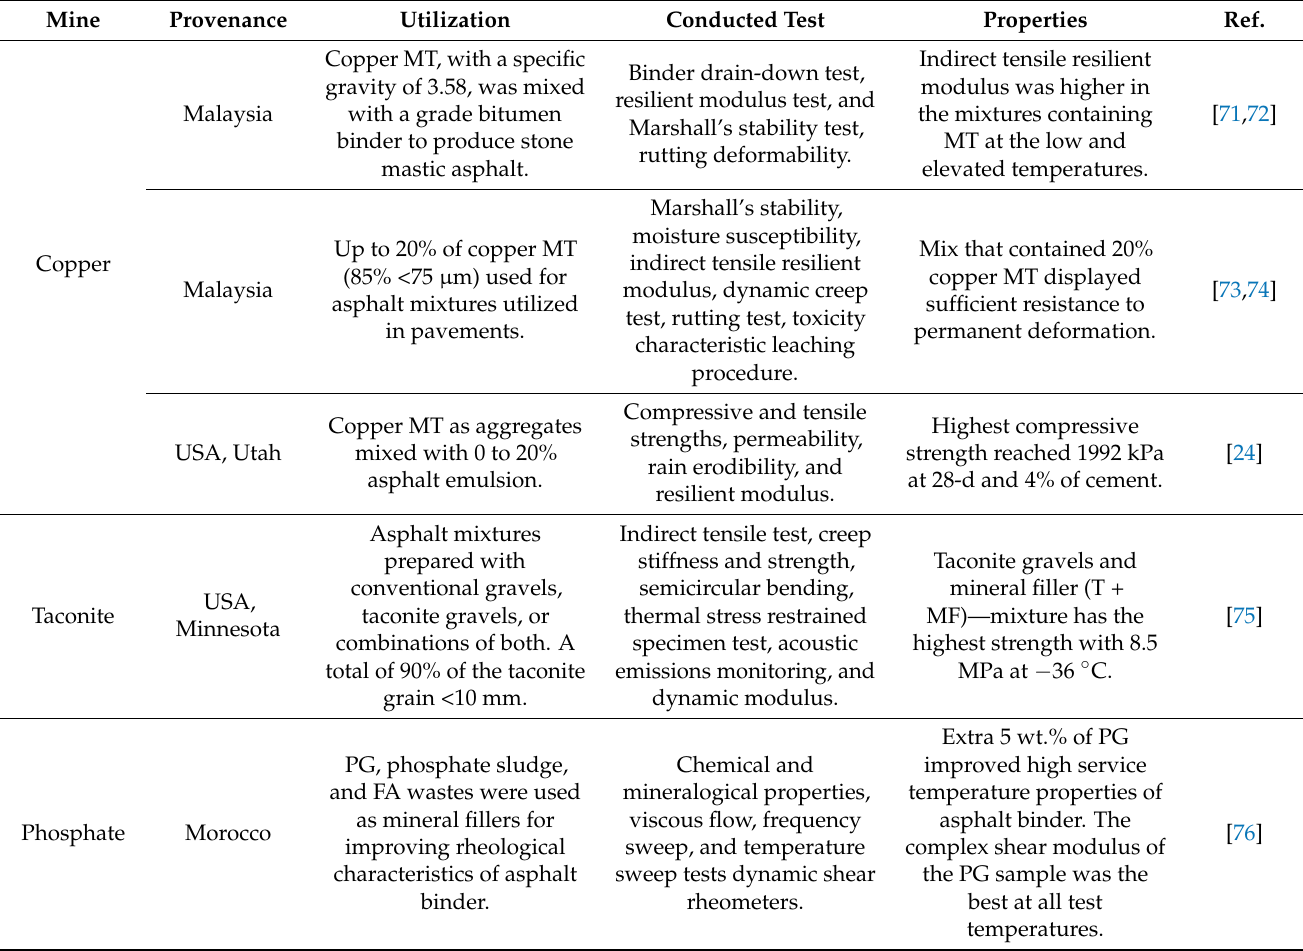
Table 5. Mine wastes used in road